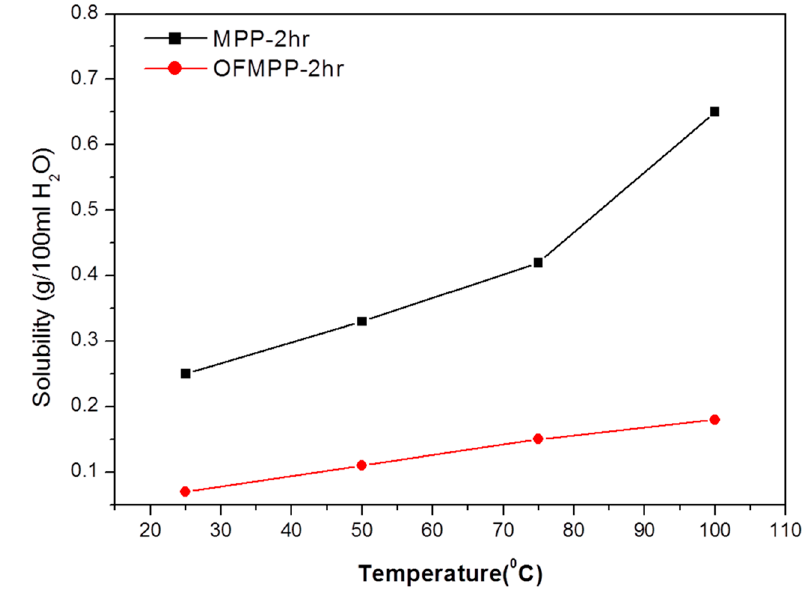
Table 2. Water solubility data of MPP and OFMPP.